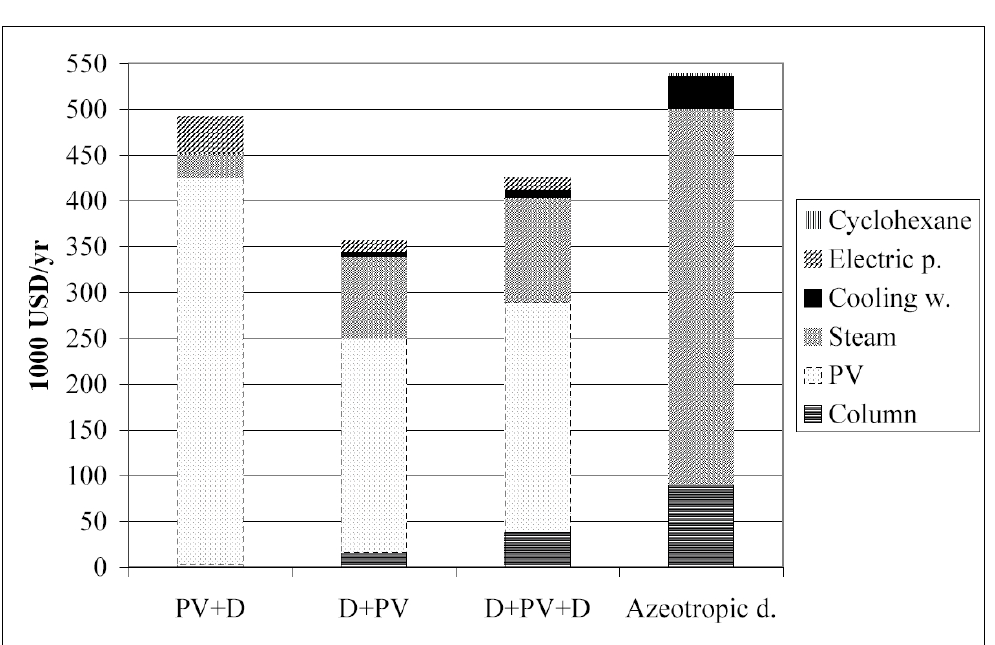
Fig. 12 Total annual cost with isothermal